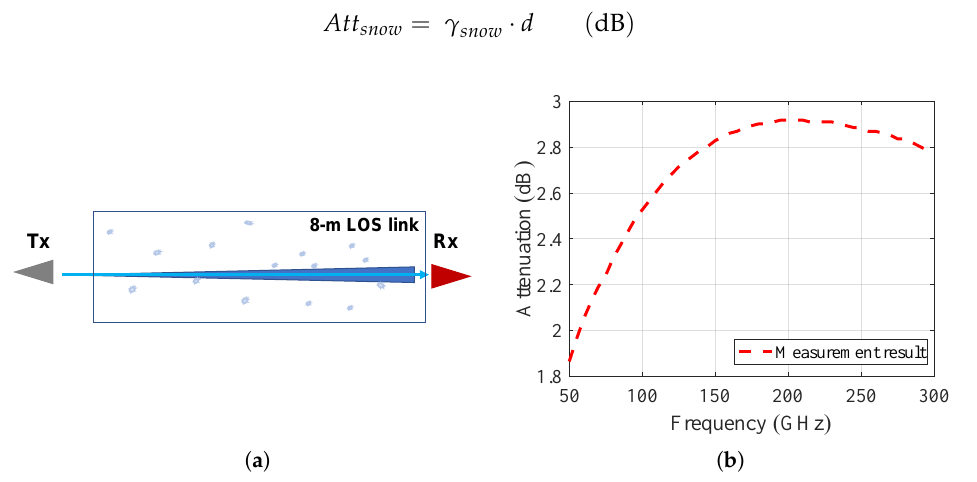
Figure 2. Attenuation caused by snow. ( a ) schematic of measurement campaign; ( b ) measured attenuation caused by snow from